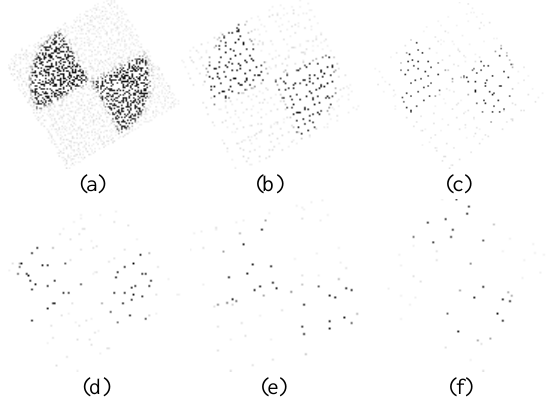
Figure 8. Orthographic reflectance images of a target from point clouds with different sample intervals: (a) 5mm (b) 10mm (c) 15mm (d) 20mm (e) 25mm (f) 30mm